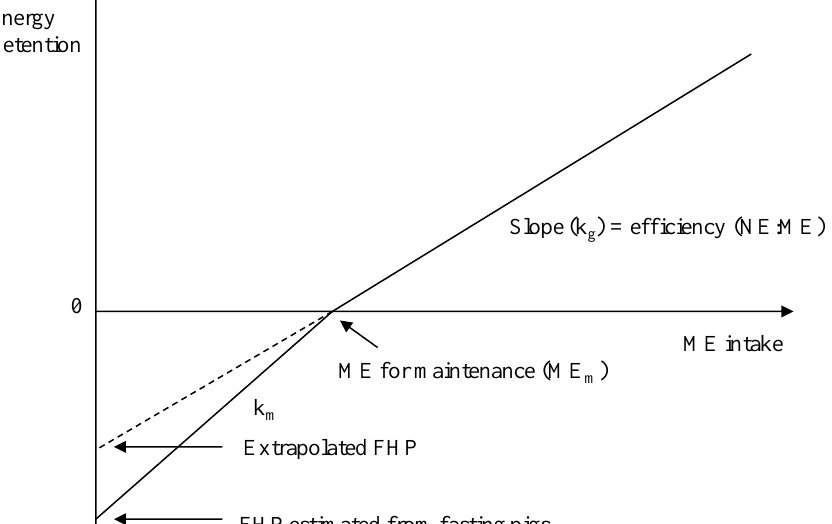
Figure 1. Estimation of the energy requirement for maintenance from energy retention (kcal/BW 0.6 /d) and energy intake (kcal/BW 0.6 /d) in pigs. Adapted from de Lange and Birkett (2005). FHP = Fasting heat